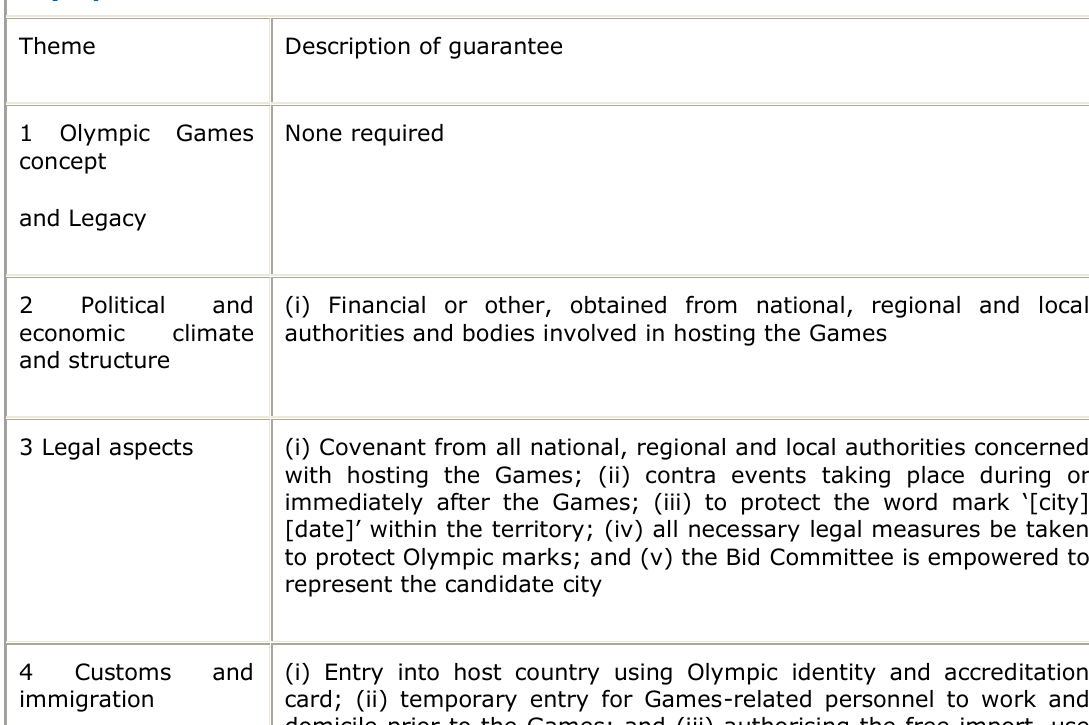
Table 1 – A Summary of the Themes and Associated Guarantees Required